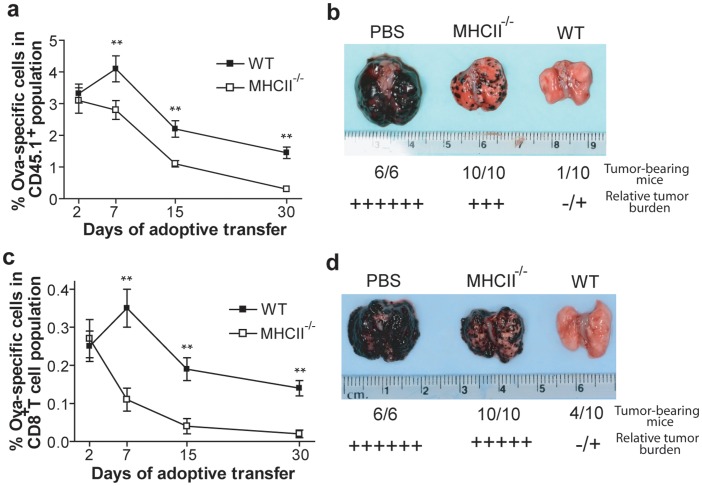
Polyclonal CD4+ T cells support maintenance of AdVova transgene product-specific CTLs.(a) Ten days following immunization, total CD8+ CTLs containing AdVova-specific effector CTLs were purified from B6.1 mice (CD45.1+ background) and adoptively transferred to naïve congenic WT and MHCII−/− mice (CD45.2+ background; ∼15×106/mouse). The OVA-specific tetramer+ CTLs were tracked after staining peripheral blood samples with tetramer reagent and congenic marker up to 30 days post-adoptive transfer. The values represent mean %±SD of OVA-specific tetramer+ CTLs in total CD45.1+ adoptively transferred T cell population at the indicated intervals (right panel) and are representative of two independent experiments with five to six mice per group. **P<0.01, versus MHCII−/− mice. (b) Forty-five days after adoptive transfer, the above mice groups were challenged with BL6-10OVA. Twenty-four days after the challenge, both groups were assessed for tumor protection. Images represent distorted pathology of lungs, showing relative surface tumor burden. (c) Ninety days following the immunization, total CD8+ T cells containing AdVova-specific memory CTLs were purified from WT mice and adoptively transferred into naïve WT and MHCII−/− mice (∼15×106/mouse). The OVA-specific tetramer+ CTLs were tracked in peripheral blood samples by tetramer staining. The values represent mean %±SD of OVA-specific tetramer+ CTLs in total CD8+ T cell population at the indicated intervals (right panel) and are representative of two independent experiments with four to six mice per group. **P<0.01, versus MHCII−/− mice. (d) Thirty days after the adoptive transfer, the above mice groups (c) were challenged with BL6-10OVA and the relative surface tumor burden was assessed 24 days after the challenge as detailed above.